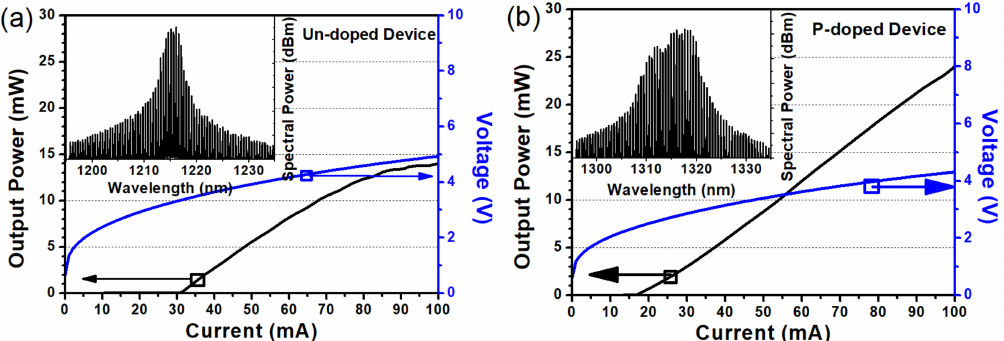
Figure 2. The power–current–voltage (P–I–V) curves of the devices. ( a ) Un-doped device and ( b ) p-doped device. The insets show the optical spectra of devices under a 65 mA bias current.